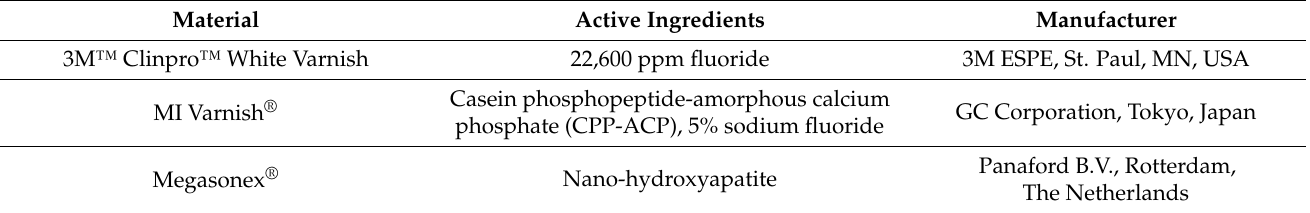
Table 1. List of the materials used in the study and their respective active ingredients. Material Active Ingredients